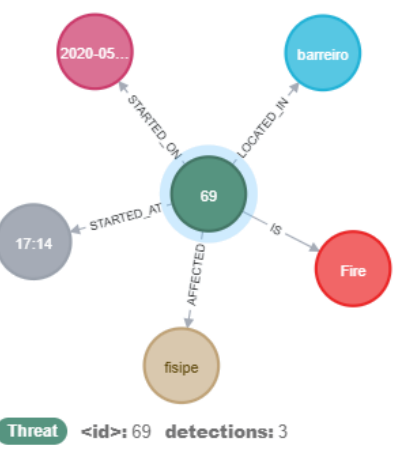
Figure 4. Knowledge graph after the first 3 tweets.